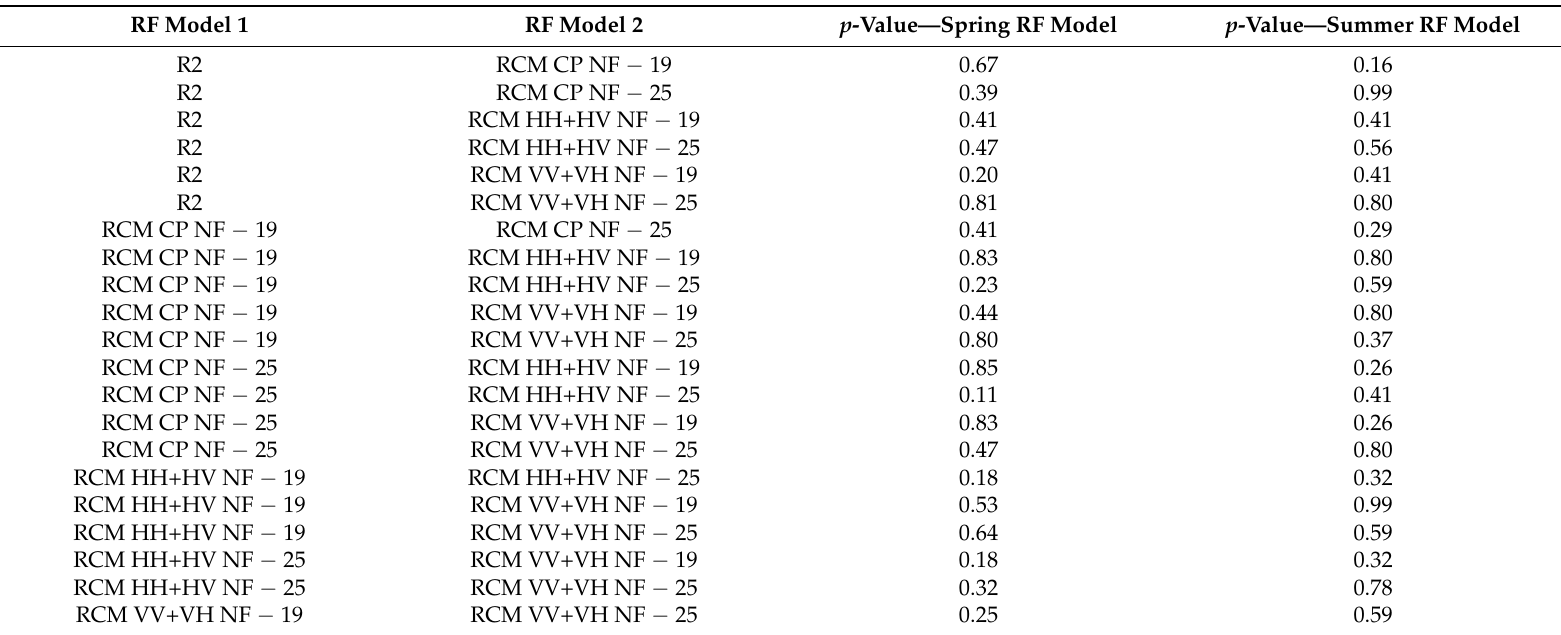
Table 5. p -values from the McNemar test statistic that was used to compare the RADARSAT-2 and simulated RCM Random Forest models with the highest independent overall accuracy. All models were not statistically different ( p -values > 0.05) at the 95% confidence level. All RF models were a combination of either RADARSAT-2 or simulated RCM data, Landsat-8, and SRTM DEM variables. The final variables in the model are listed in the appendix. The same validation points used to calculate the independent overall accuracy were used in the McNemar